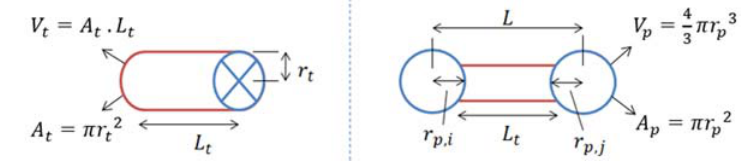
Figure 6. Geometric information about pores and throats.